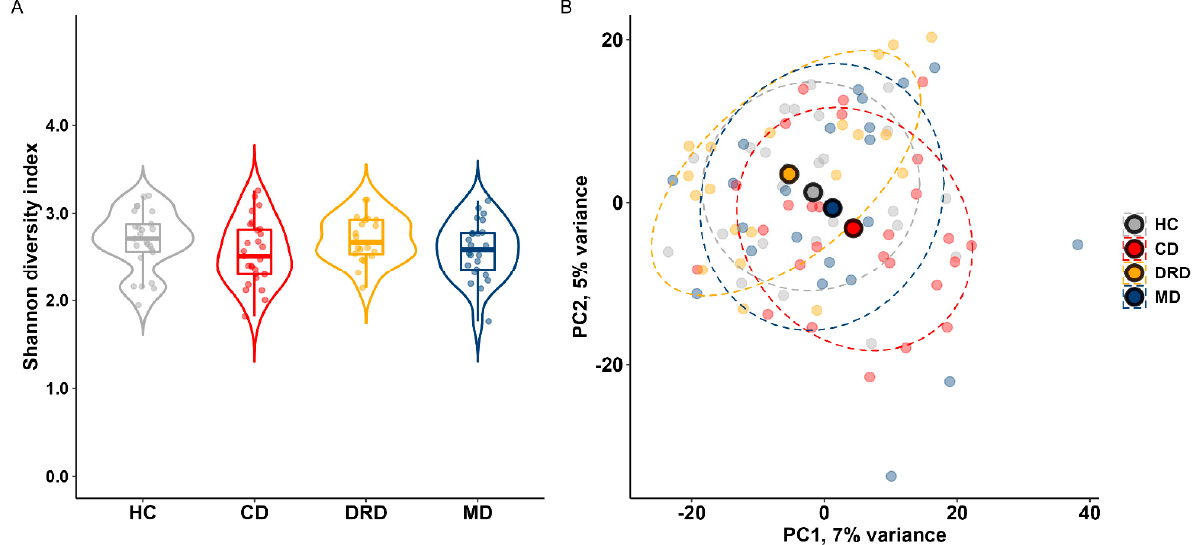
Figure 1. ( A ). violin plot depicting the Shannon diversity index, a quantitative measure for the number and abundance of species within a sample. We found no significant differences in Shannon diversity index ( p > 0.05). ( B ). Principal component plot based on Aitchison distance for dystonia patients and healthy controls. PC: principal coordinate; HC: healthy controls; CD: cervical